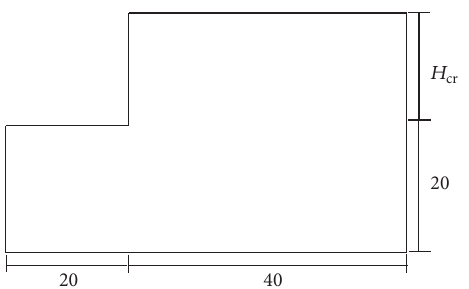
Figure 3: Calculation model of vertical slope (unit: m).